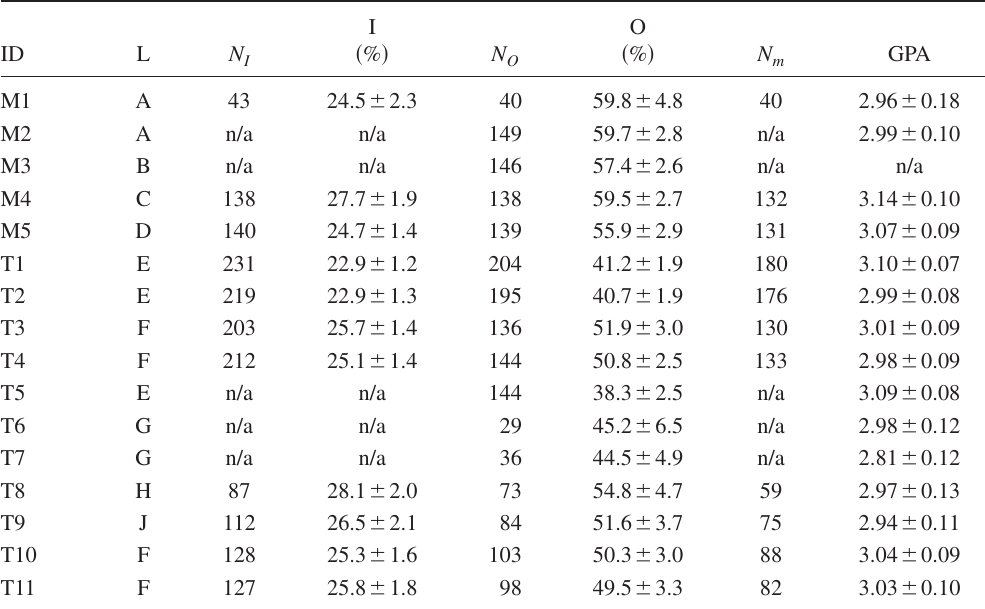
TABLE I. Georgia Tech BEMA test results are shown for five Matter & Interactions sections (cid:1) M1–M5 (cid:2) and 11 traditional sections (cid:1) T1–T11 (cid:2) . Different lecturers are distinguished by a unique letter in column L . (cid:1) Note that lecturer B in M3 was assisted by lecturer A. (cid:2) The average BEMA score O for N completing the course is shown for all sections. Moreover, in those sections where data are available, the average BEMA score I for N I students entering the course is indicated. N m is the number of students in a given section who took the BEMA both at the beginning and at the end of their E&M course. GPA is the incoming cumulative grade point average for students in a given